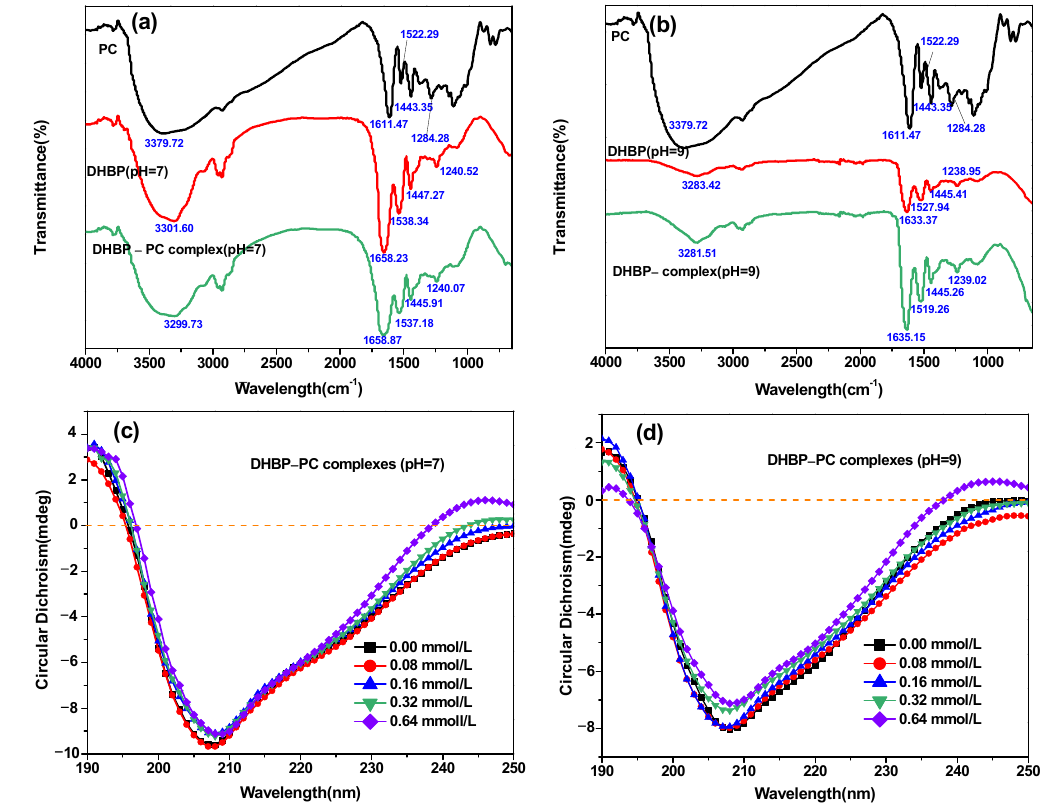
Figure 4. Fourier transform infrared spectra ( a , b ) and circular dichroism chromatography ( c , d ) analysis of decolorized highland barley protein (DHBP)–proanthocyanidin (PC) complexes.